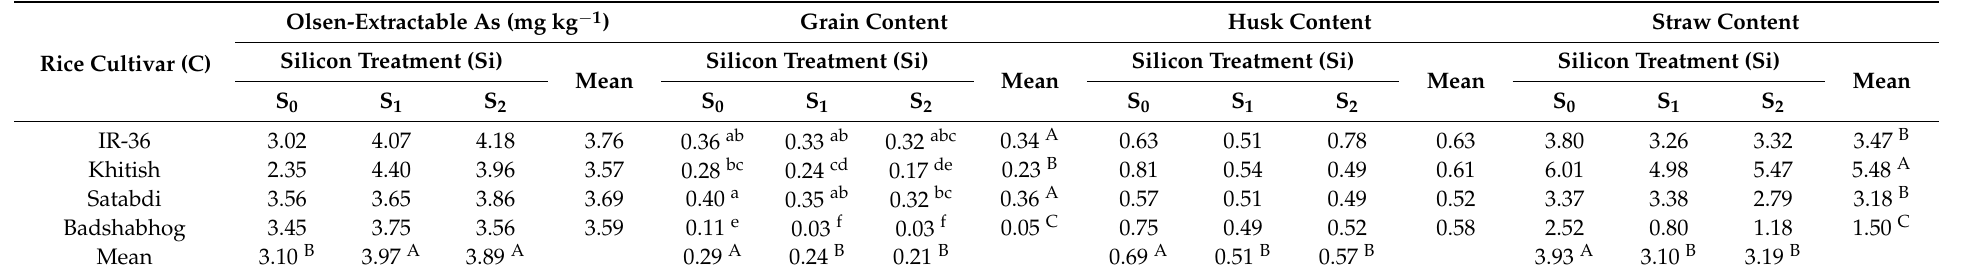
Table 2. Effect of the sodium metasilicate (Na 2 SiO 3 ) addition on extractable As (mg kg − 1 ) in soil and As content (mg kg − 1 ) in the grain, husk, and straw of different rice cultivars